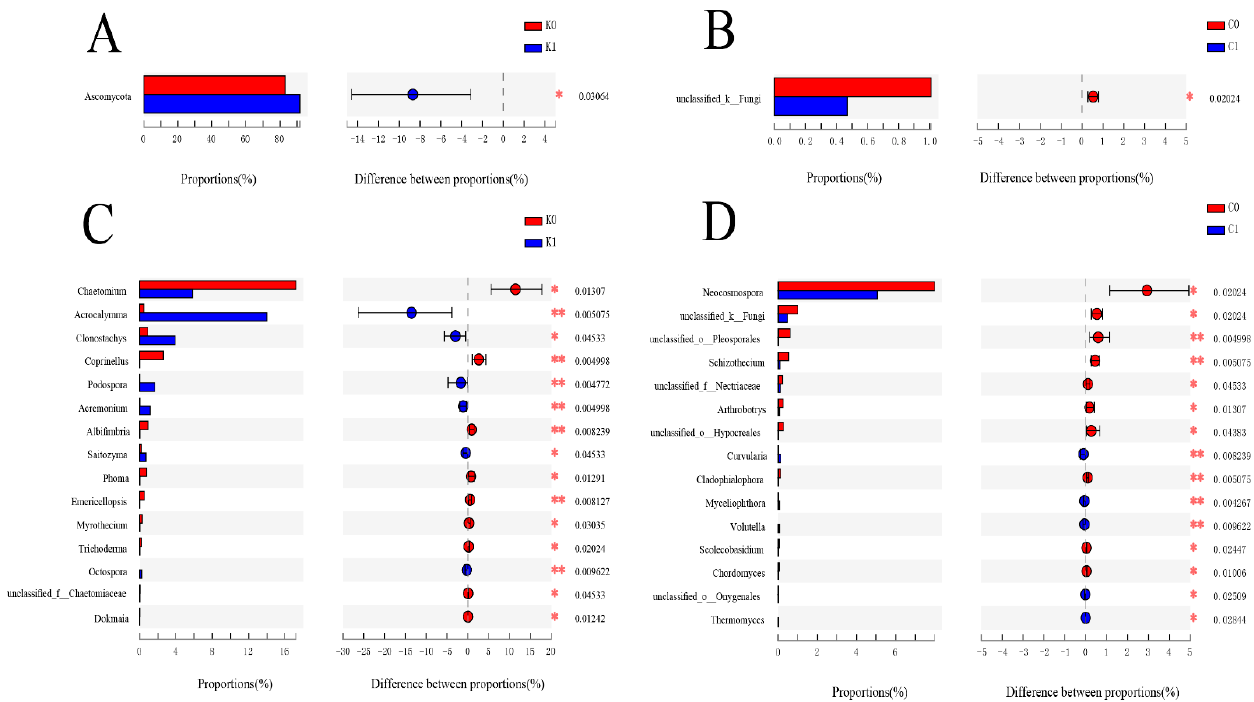
Figure 3. Two groups of comparison based on phylum and genus levels with K fertilizer and biochar addition. ( A , B ) and ( C , D ) represent the statistical results at phylum and genus levels, respectively. p < 0.05 marked as *, p < 0.01 marked as **.